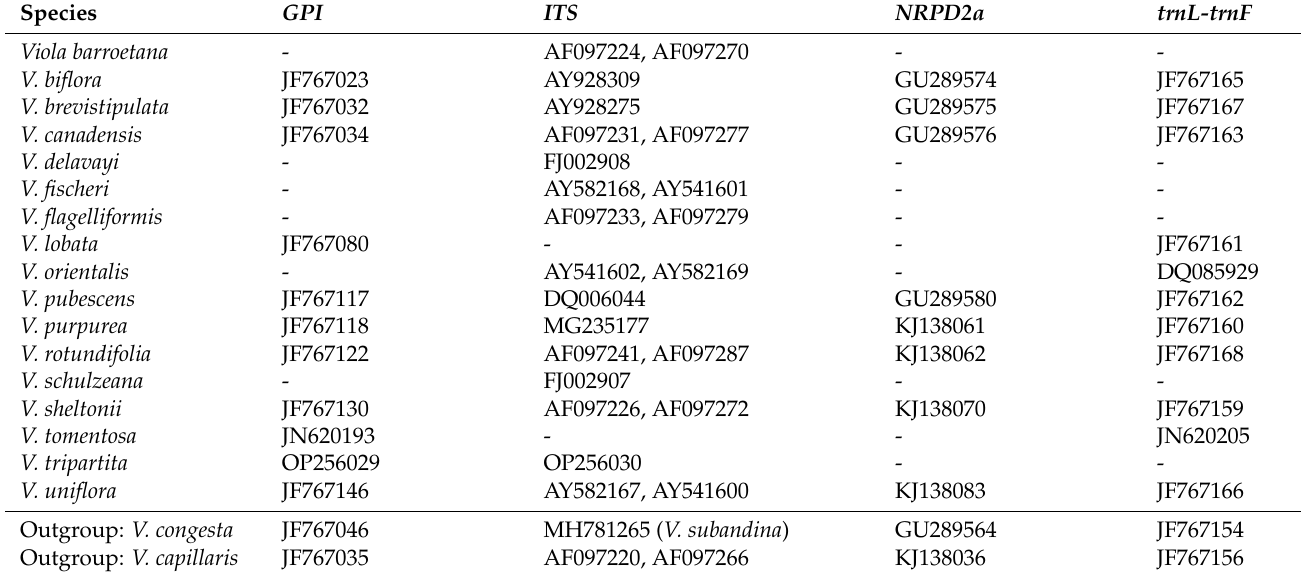
Table 5. Taxa and GenBank sequence IDs for the phylogenetic analysis of sect. Chamaemelanium . A dash indicates missing data. Metadata for each sequence are available at